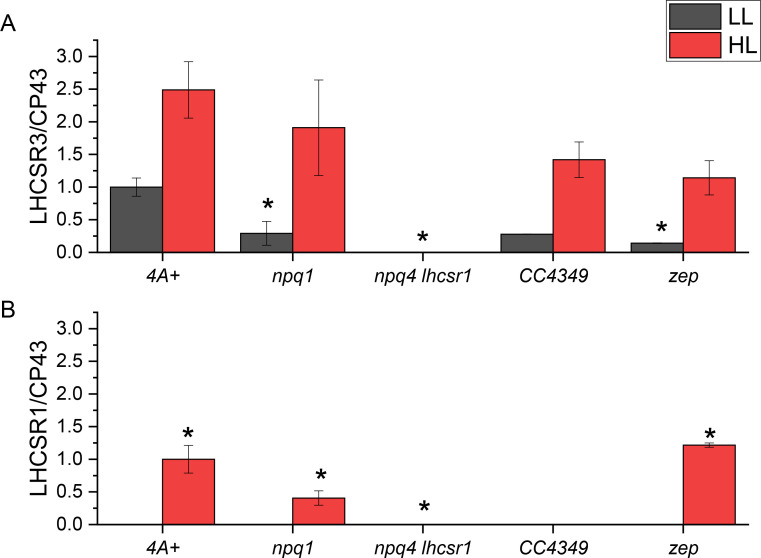
Quantification of LHCSR3 and LHCSR1 accumulation per PSII.Immunoblotting results were analyzed by densitometry. LHCSR3 (A) and LHCSR1 (B) content was then normalized to the amount of CP43 as a reference for PSII. The results obtained were then normalized to the 4A+ low light (LL) case in the case of LHCSR3 and 4A+ high light (HL) case in the case of LHCSR1. The results reported are representative of two independent experiments with different biological replicates and three technical replicates for each genotype in LL or HL. Error bars are reported as standard deviation. The statistical significance of differences compared to WT (4A+ for npq1 and npq1 lhcsr1 mutants, CC4349 for zep mutant) is indicated as * (p<0.05), as determined by unpaired two sample t-test (N = 3).